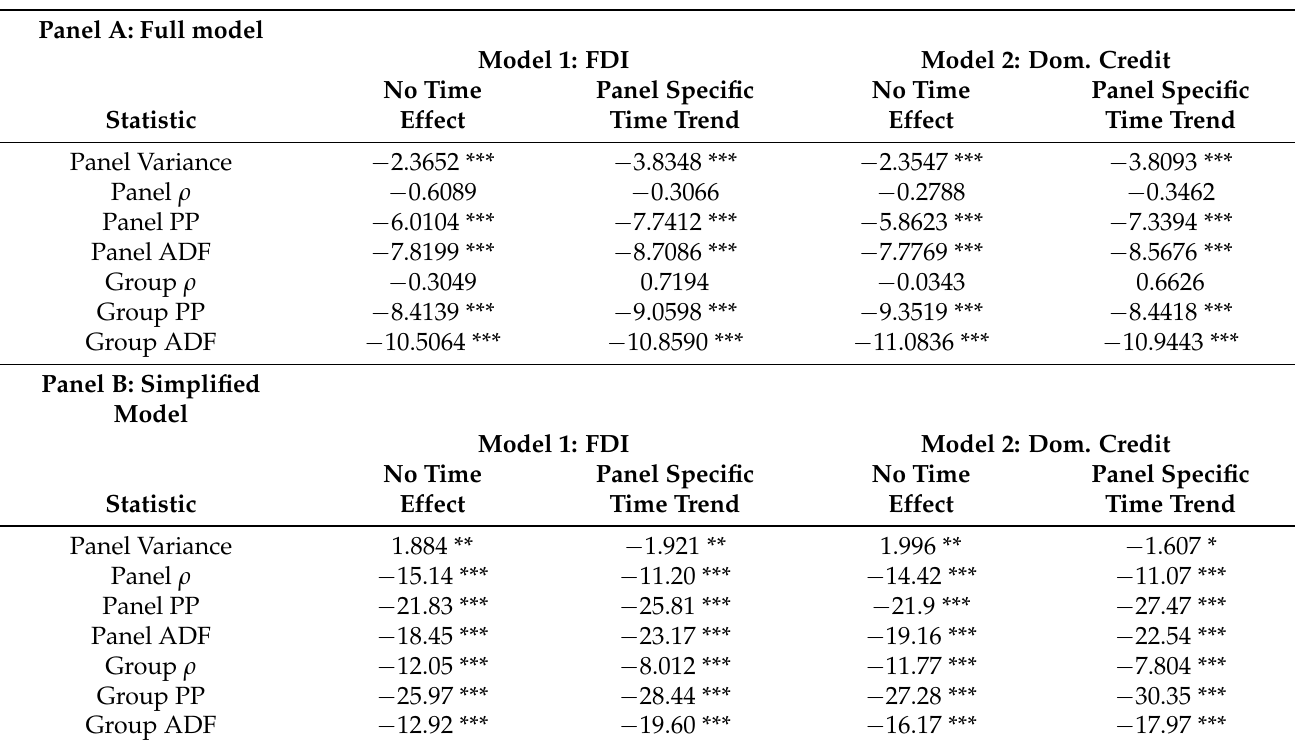
Table 3. Results of the panel cointegration tests.